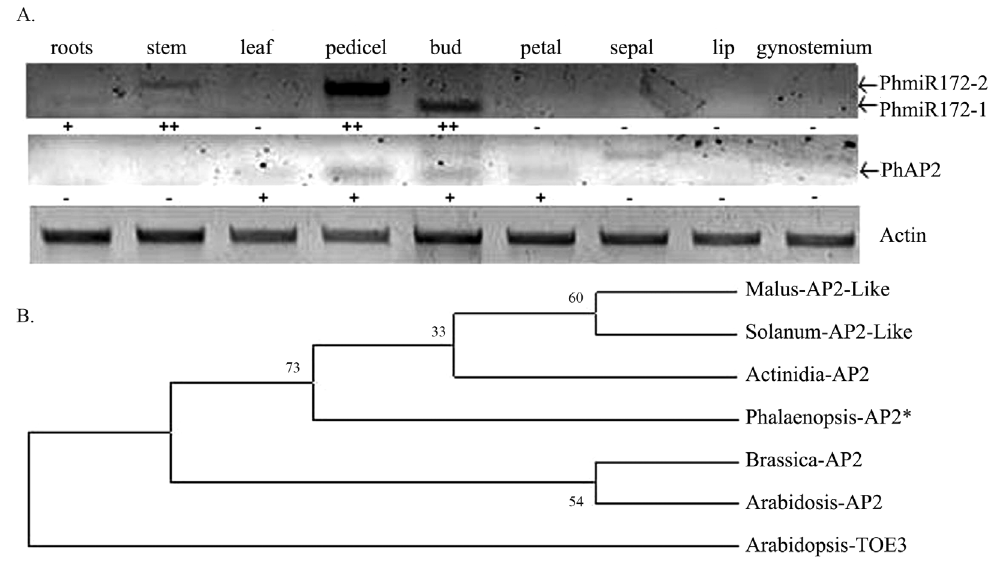
Figure3 -Semi-quantitativeRT-PCRanalysesof PhmiR172s anditstarget PhAP2 geneindifferenttissuesof P.hybrida .(A)Semi-quantitativeRT-PCR of PhmiR172s (+: expression of PhmiR172-1 ; ++: expression of PhmiR172-1 and PhmiR172-2 ; -: no expression) and PhAP2 (+: expression; -: no expres- sion). (B) Phylogenetic analysis of PhAP2 and AP2 sequences from other